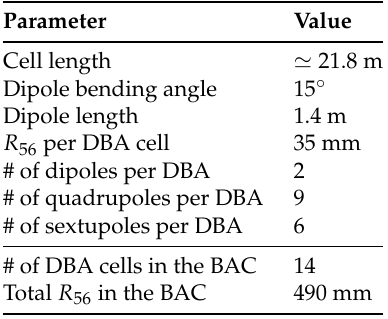
Table 1. DBA and BAC main parameters.